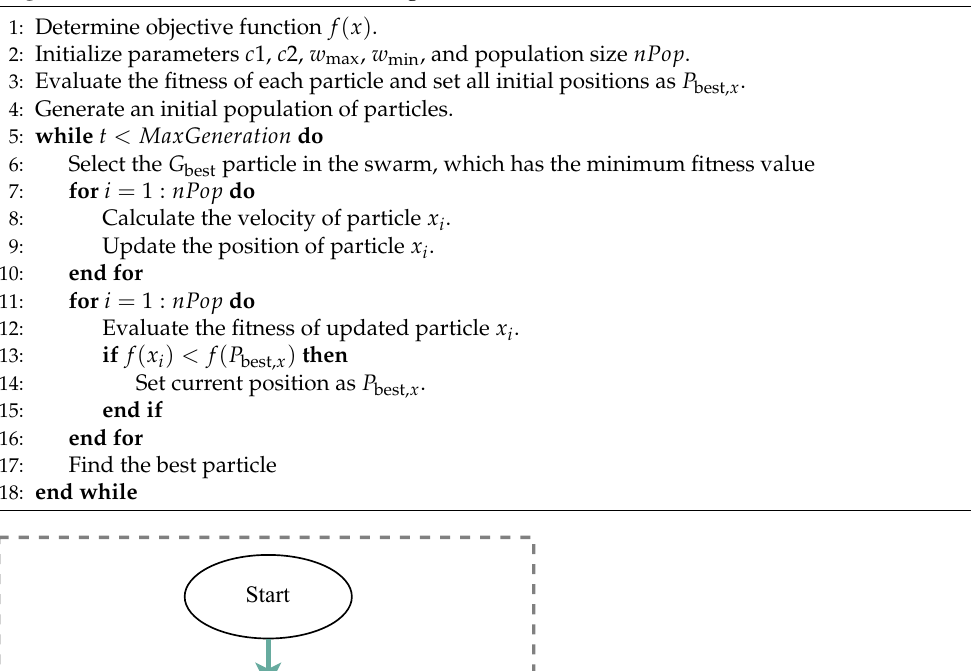
Algorithm 3 Pseudo-code for PSO Algorithm.